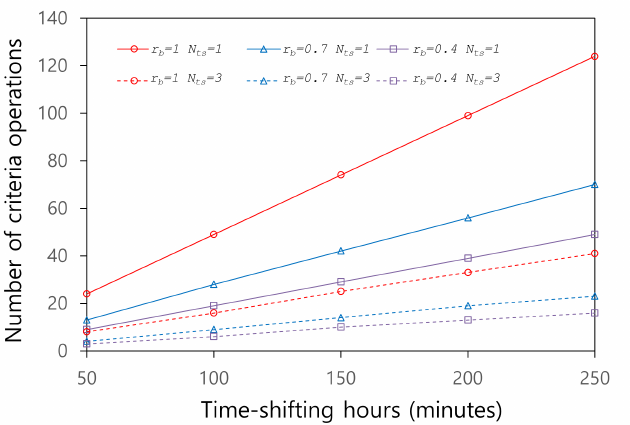
Figure 15. The number of criteria determination operations according to time-shifting hours with a 300 s